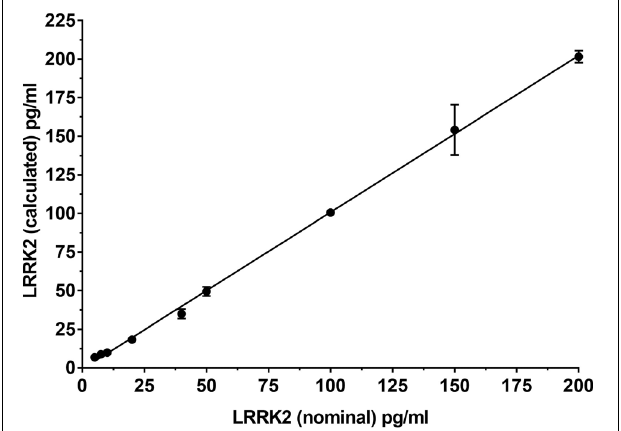
FIGURE 2 | Calibration curve using recombinant LRRK2 from 5–200 pg/ml. Curve includes LQC (7.5 pg/ml), MQC (40 pg/ml) and HQC (150 pg/ml) samples. Curve was run a total of six times and showed acceptable